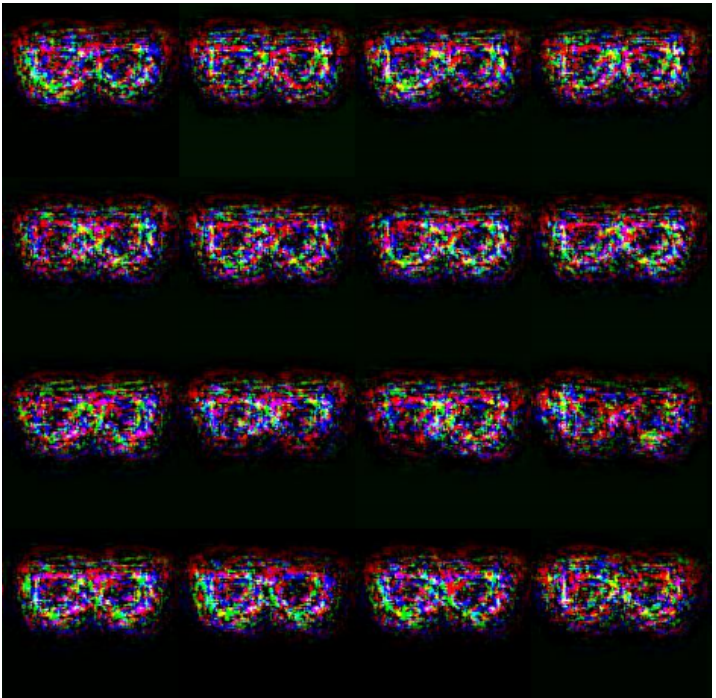
Figure 2. Generated adversarial